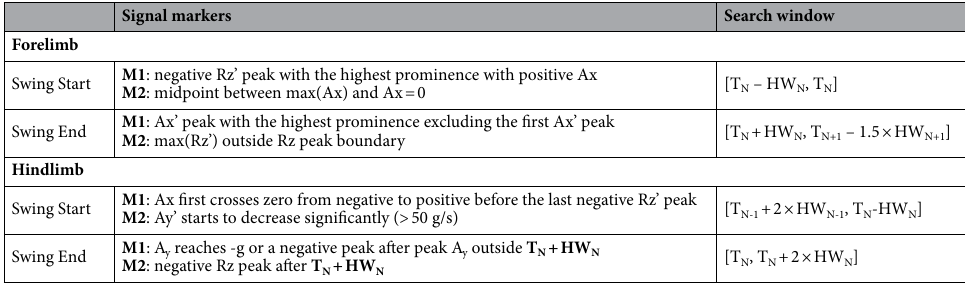
Table 1. IMU signal markers and search windows for detection of swing start and end time positions in forelimb and hindlimb strides.